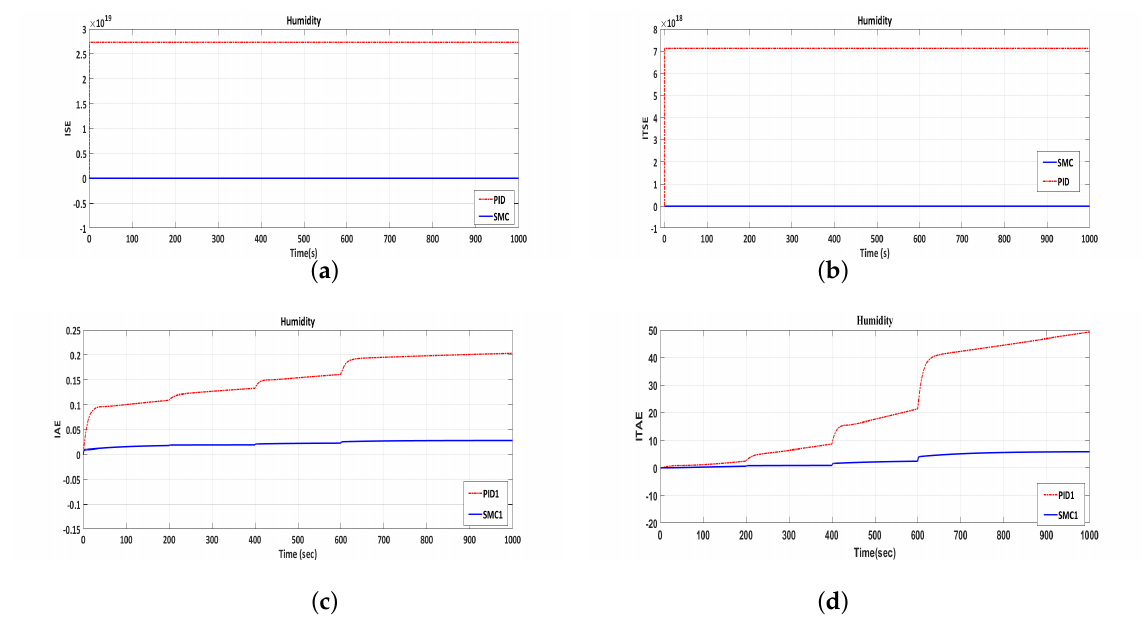
Figure A2. Performance indices ( a ) ISE, ( b ) ITSE, ( c ) IAE, ( d ) ITAE graphs of controllers for humidity output of the first reference signal, sequence of steps.